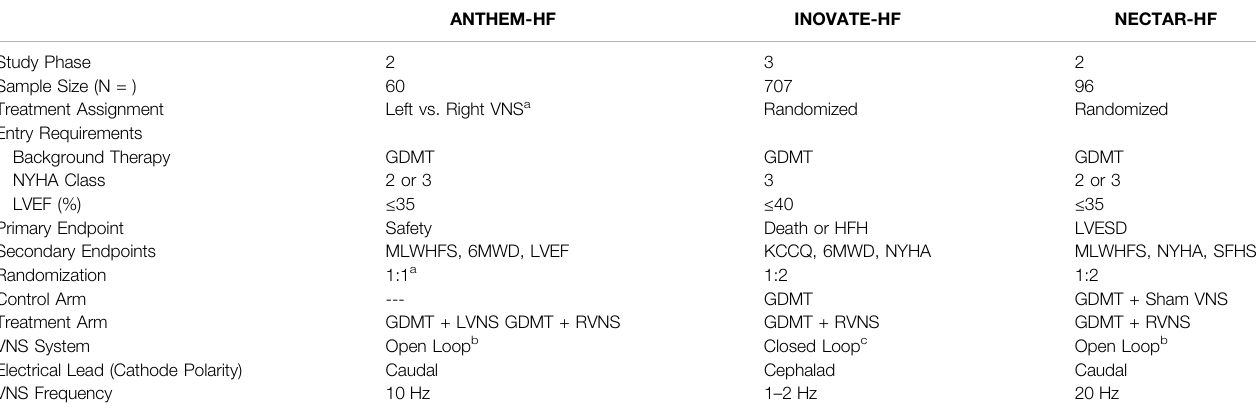
TABLE 2 | Similarities and differences among ANTHEM-HF, INOVATE-HF, and NECTAR-HF study designs. ANTHEM-HF INOVATE-HF NECTAR-HF Study Phase 2 3 2 Sample Size (N = ) 707 96 Treatment Assignment Left vs. Right VNS a Randomized Randomized Entry